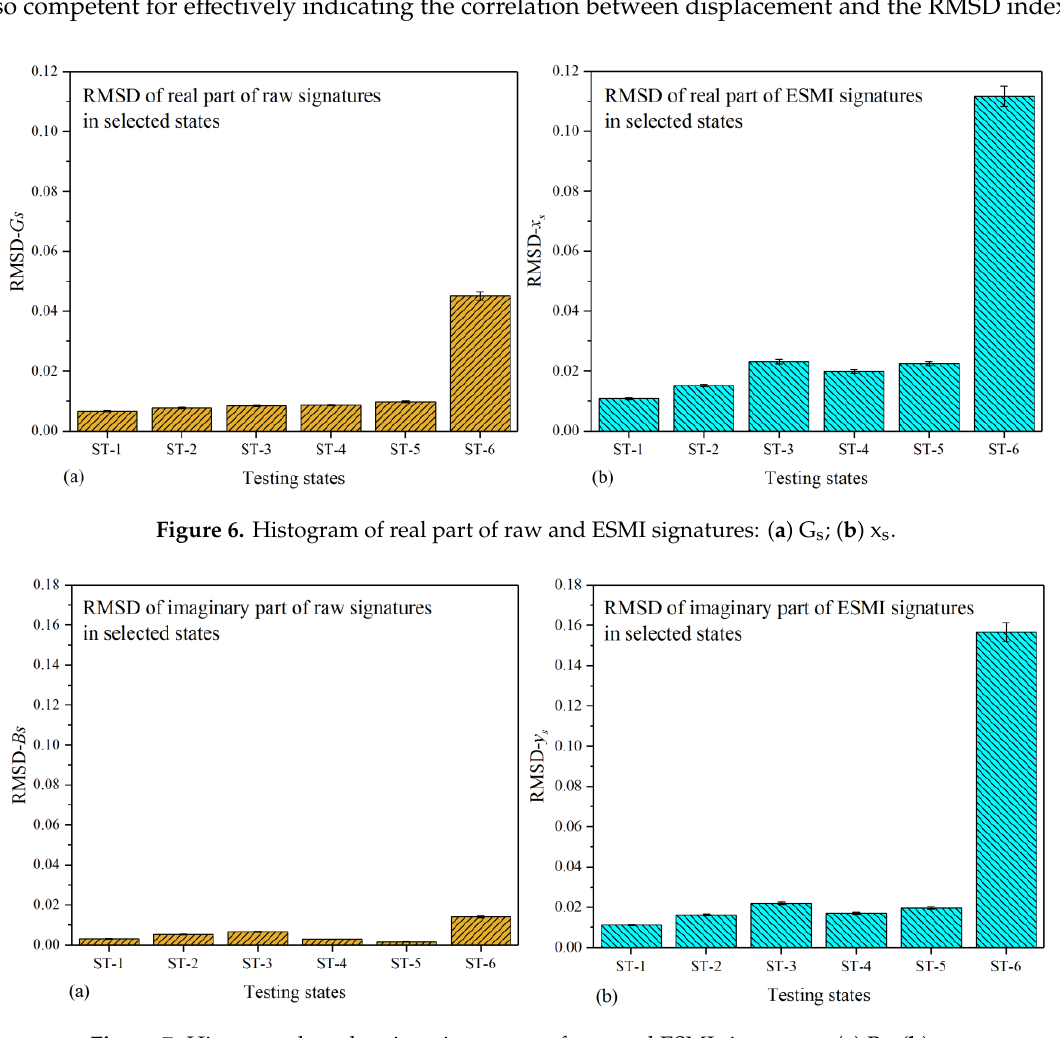
10 of 18 Figure 5. Imaginary part plot of raw and ESMI signatures: ( a ) B s ; ( b ) y s . 4.2. Characterization of Single-Lap Joint Condition with RMSD Index Despite the curves in Figures 4 and 5 showing the correlation between tensile displacement and measured signatures, no intuitive enough regularity could be found. Hence, to solve this problem, the index of RMSD was adopted. As mentioned above, the curves in Figure 4b and 5b show very obvious peaks (Peak-1 to Peak- 5); thus, a novel signature processing method was developed based on the extracted ESMI signatures,